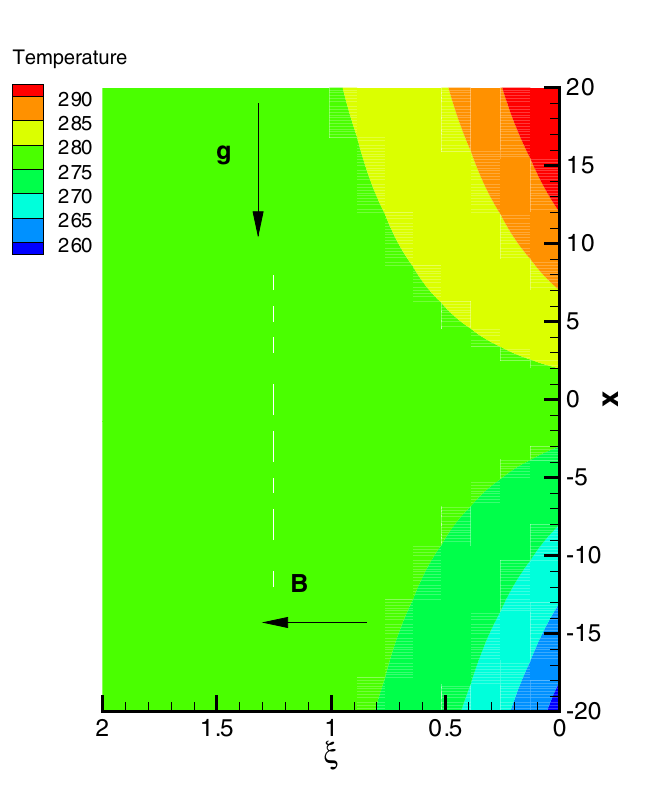
Fig 13. Isotherms for T 1 = 278 K , Pr = 10, γ = 0.2, λ = 1.